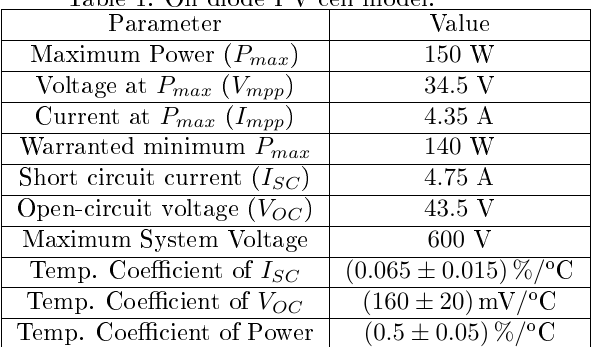
Table 1. On diode PV cell model. Parameter